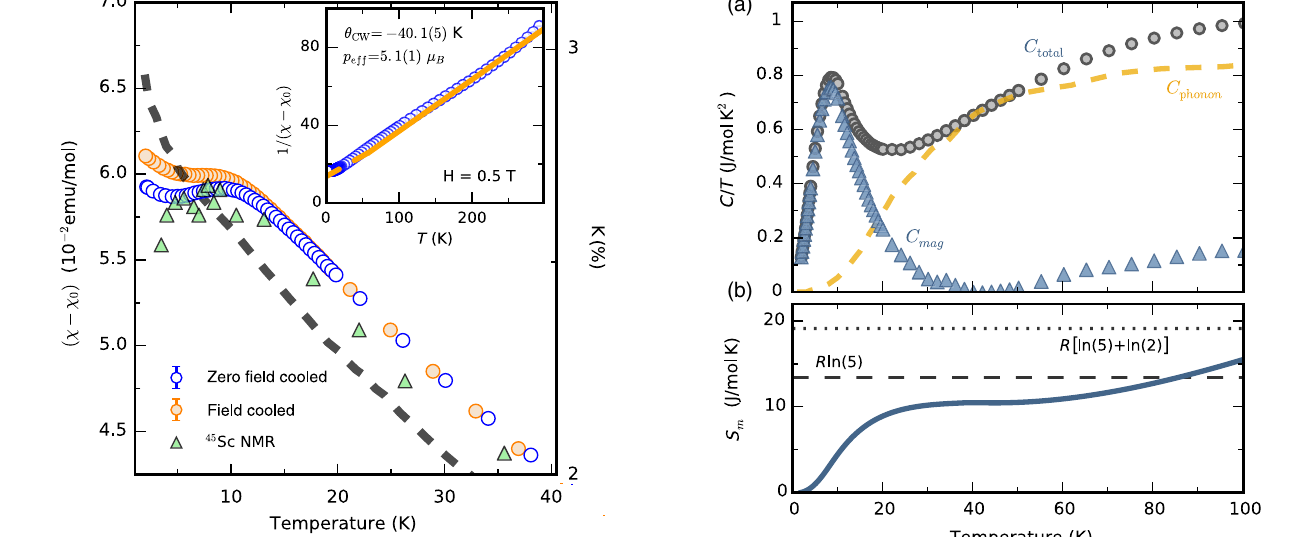
FIG. 3. Specific heat for powder samples of FeSc 2 S 4 used in this work. (a) Total specific heat (gray circles) and estimated magnetic contribution (blue triangles). Dashed yellow line is the estimated phonon contribution. (b) Estimated magnetic entropy of FeSc 2 S 4